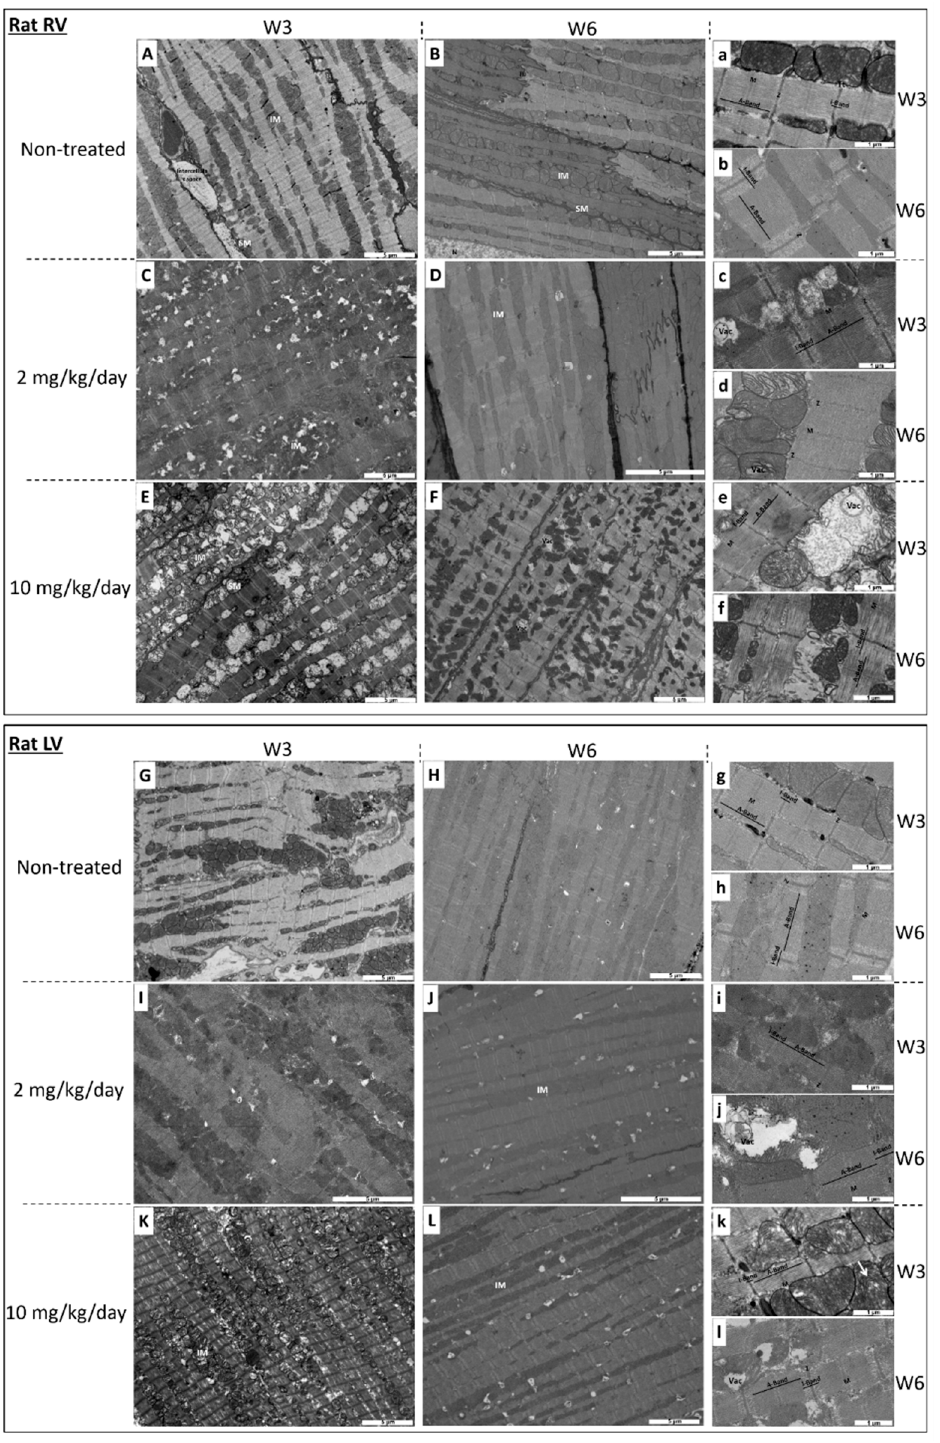
Figure 1. Transmission electron micrograph of right ventricle (RV) and of the left ventricle (LV) in rats at week 3 (W3) ( A , a , C , c , E , e for RV and G , g , I , i , K , k for LV) and at week 6 (W6) (3-weeks drug washout) ( B , b , D , d , F , f for RV and H , h , J , j , L , l for LV). ( A , a , B , b , G , g , H , h ): non-treated rats. ( C , c , D , d , I , i , J , j ): 2 mg I-BET-151/kg/day treated rats. ( E , e , F , f , K , k , L , l ): 10 mg I-BET-151/kg/day treated rats. SM indicates sub-sarcolemmal mitochondria; IM, interfibrillar mitochondria; Vac, vacuole; Tt, T tubule; M, M line; Z, Z line. Bar scale is indicated on each micrograph. Selection of the most representative pictures from three animals per group.